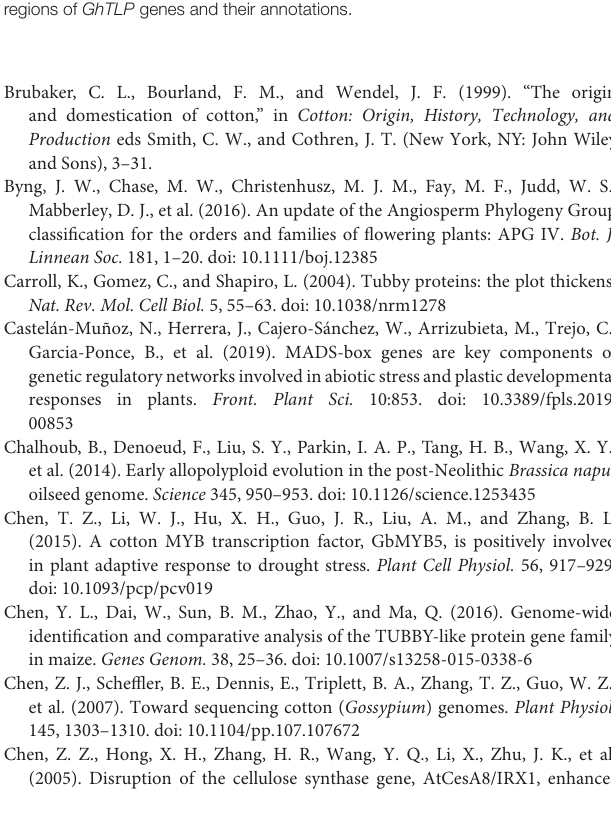
Supplementary Table 6 | A list of positively and negatively co-expressed genes (Pearson correlation coefficient r ≥ 0.95/ r ≤ − 0.95) with GhTLP711A and GhTLP12A.1 in salt stress. Supplementary Table 7 | A list of positively and negatively co-expressed genes (Pearson correlation coefficient r ≥ 0.95/ r ≤ − 0.95) with GhTLP711A and GhTLP12A.1 in drought stress. Supplementary Table 8 | Identified miRNAs and their